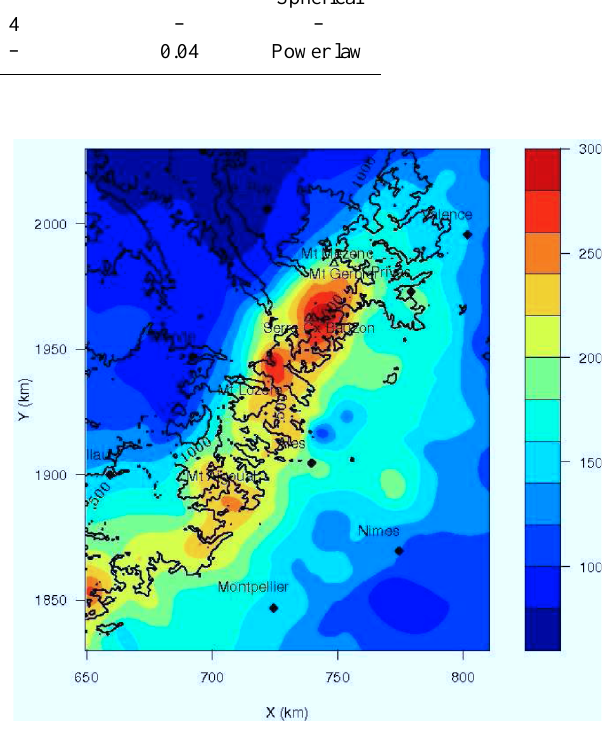
Fig. 6. 100-yr return levels estimated by RS ref on the C´evennes- Vivarais data